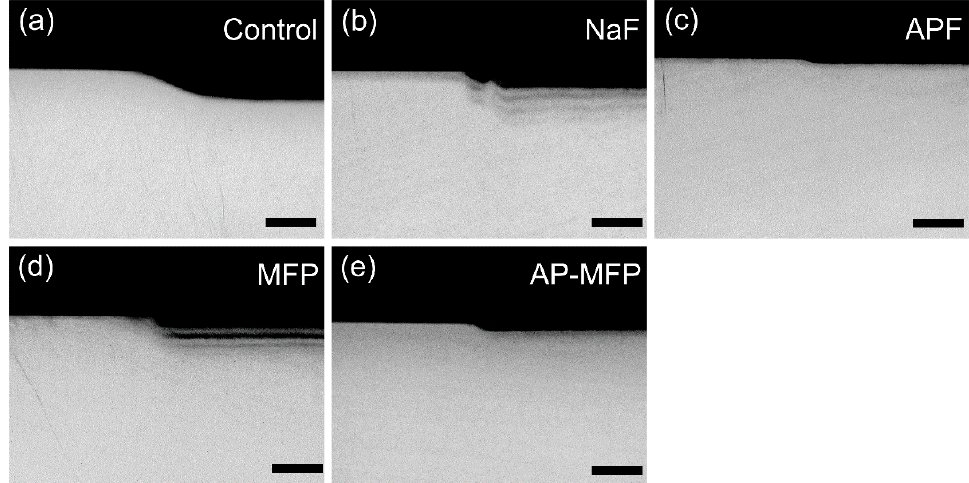
Figure 4. Boundary CMR cross-sectional images of the reference and experimental surfaces after the acid challenge: ( a ) control; ( b ) NaF; ( c ) APF; ( d ) MFP; and ( e ) AP-MFP groups. Scale bar is 100 μ m. The left side of Figure ( a – e ) shows the RS protected by wax and not demineralized. The right side shows the ES that has been demineralized.